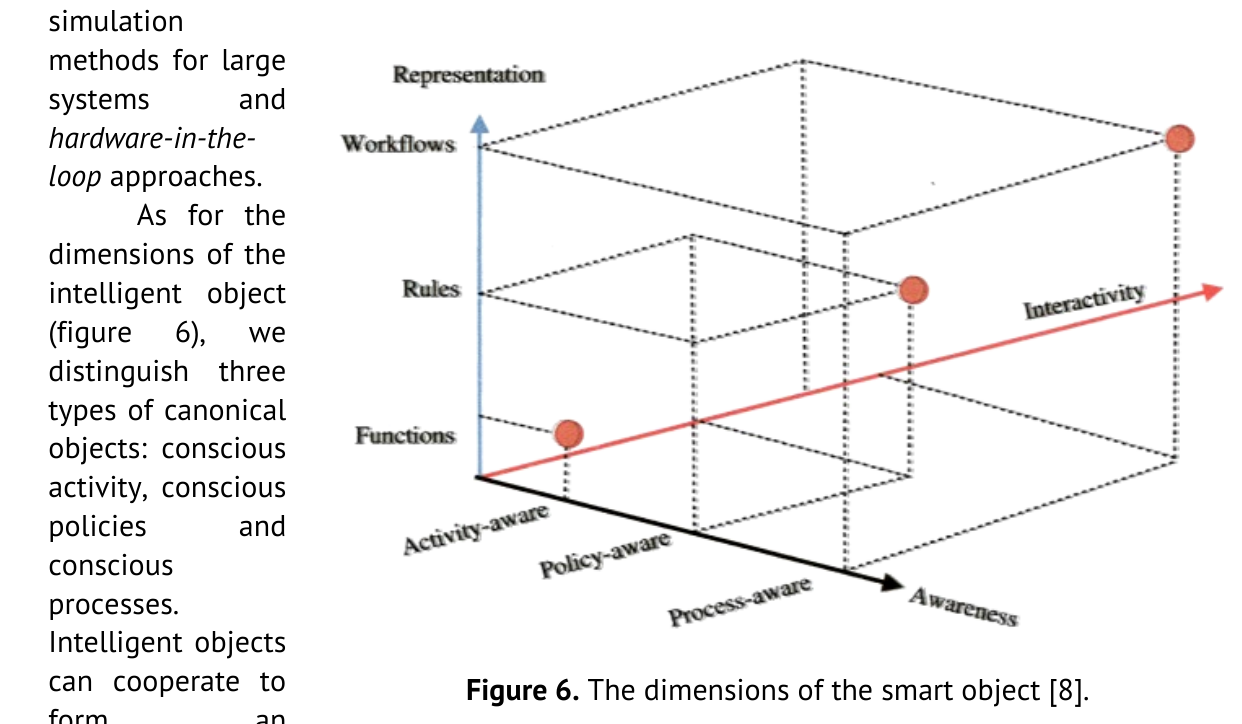
Figure 6. The dimensions of the smart object